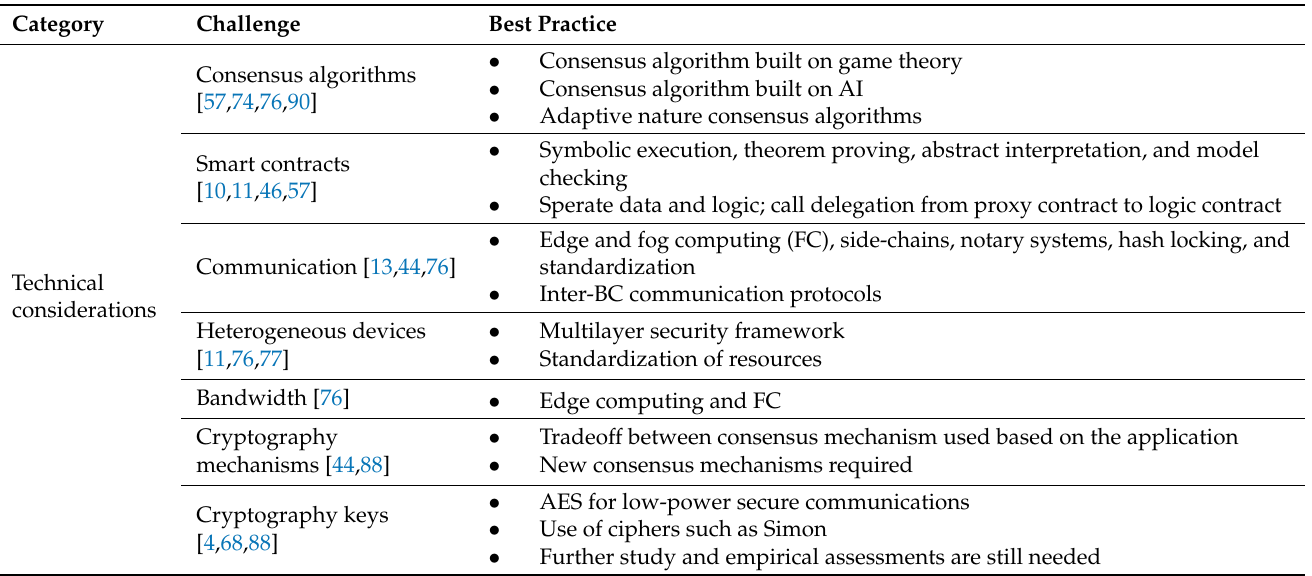
Table 8. Recommendations for reducing the negative impact of technical